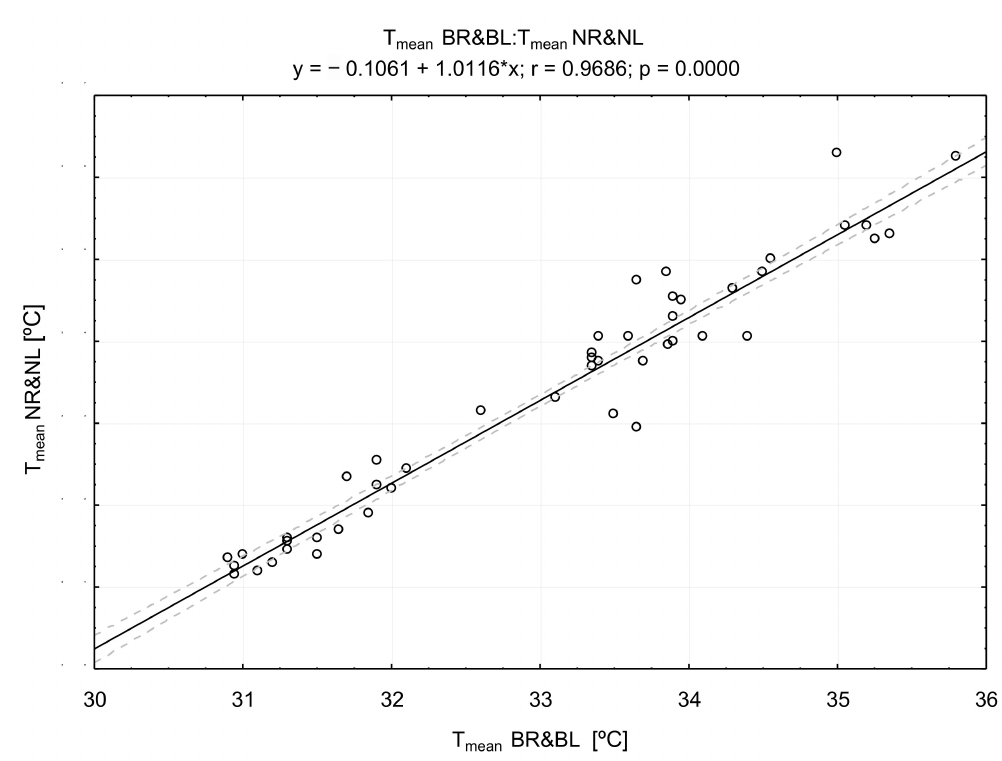
Figure 2. The result of the correlation between the values of breast (BR & BL) and nipple (NR & NL) temperatures (T mean ).